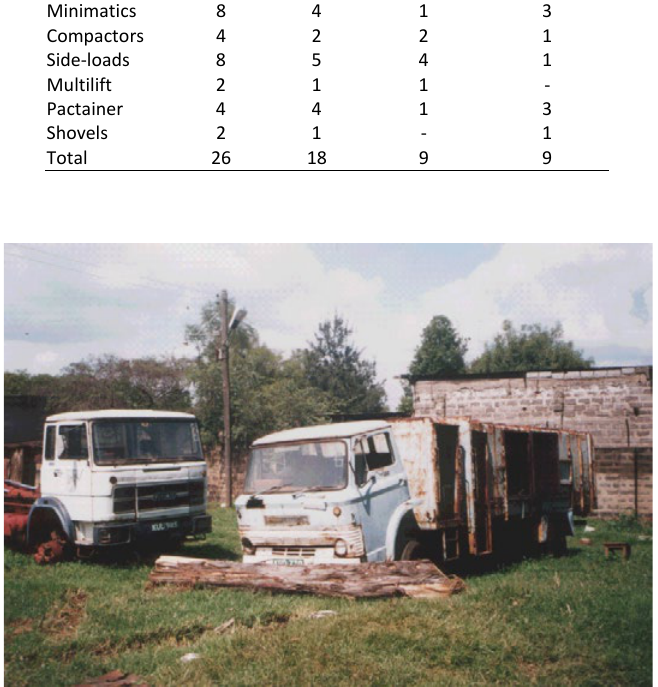
Fig. 3: Grounded solid waste collection vehicles